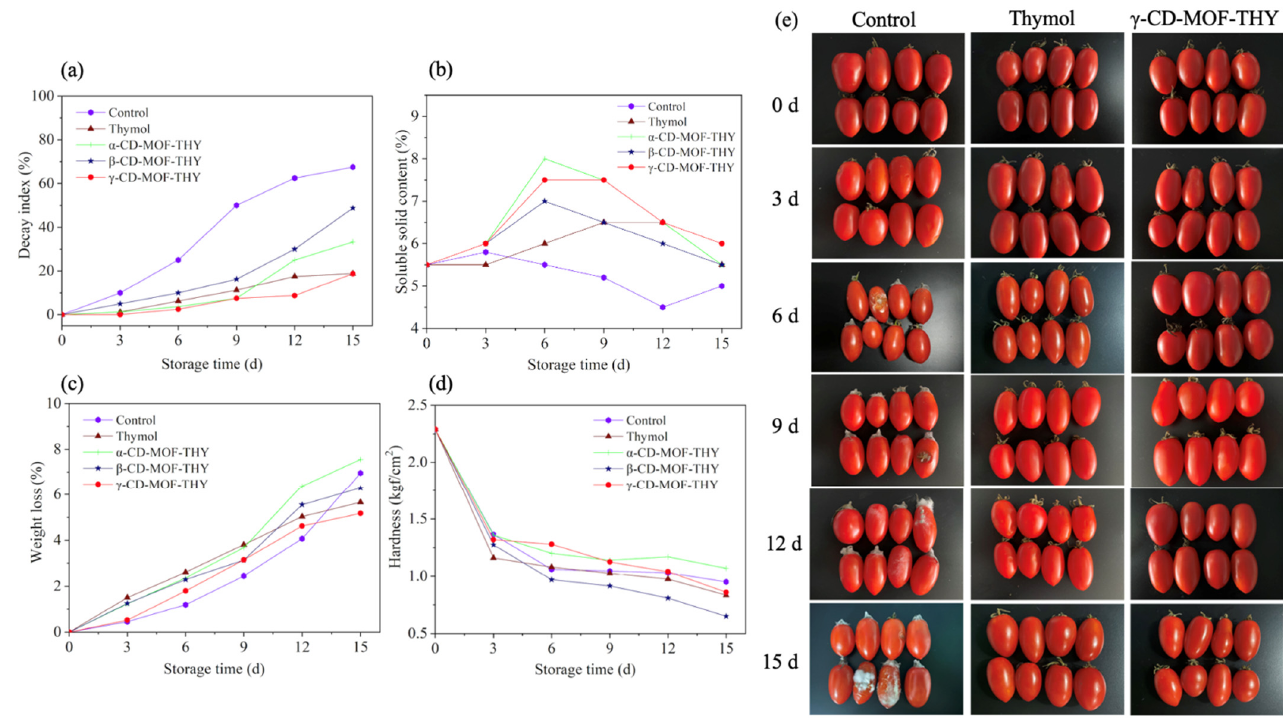
Figure 3. Decay index ( a ), soluble content ( b ), weight loss ( c ) and hardness ( d ) change of the whole cherry tomatoes treated in different groups of thymol ICs. Appearance ( e ) of the whole cherry tomatoes treated in the control group, thymol group and γ -CD-MOF-THY group. The loss of fruit mass during storage is partly induced by respiratory consumption, and the weight loss rate is an essential index to evaluate fruit quality. It can be learned